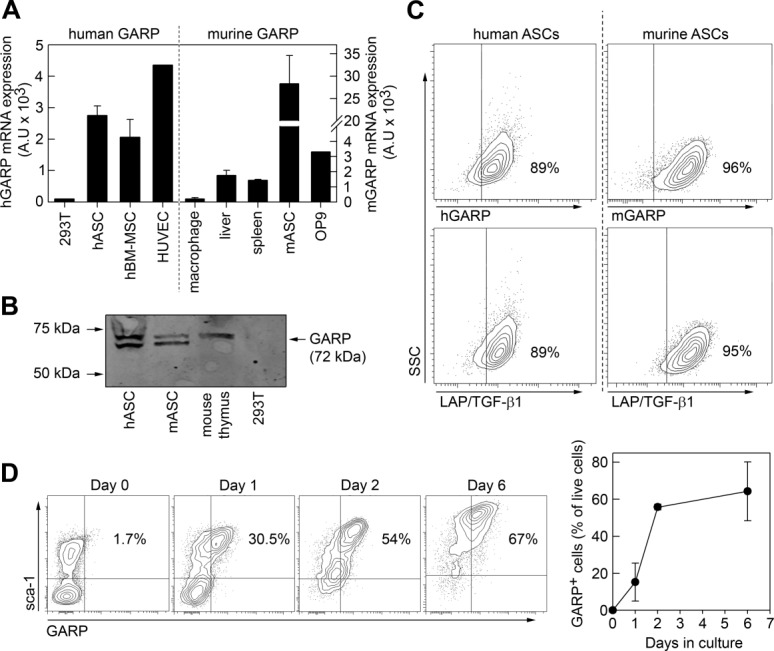
MSCs express GARP and LAP/TGF-β1 on their surface. (A): RT-qPCR analysis of GARP expression in human (left) and mouse (right) MSCs. hASCs and hBM-MSCs were analyzed together with human negative (293T) and positive (HUVEC) cell lines. Murine MSCs from adipose tissue (mASCs) and the MSC-line OP9 are shown in the right panel. As controls for murine samples we used BM-derived macrophages, mouse liver, and spleen. (B): Total protein from hASCs, mASCs, murine thymocytes, and 293T cells were analyzed by Western blot using an anti-mouse/human GARP antibody. (C): EDTA-harvested human and murine ASCs were stained for GARP (top) and LAP/TGF-β1 (bottom) surface expression and analyzed by flow cytometry. (D): Fat tissue from BALB/c mice was treated with collagenase type I and the resulting cell suspensions were stained for GARP and sca-1 expression before (day 0) and 1, 2, and 6 days after in vitro culturing and analyzed by flow cytometry. (A) and (D) show mean (SEM) of three independent experiments; (B) and (C) show a representative experiments out of >3. Abbreviations: GARP, glycoprotein A repetitions predominant; hASC, human mesenchymal stromal cells from adipose tissue; hBM, human bone marrow; LAP, latency-associated peptide; MSC, mesenchymal stromal cell; TGF-β1, transforming growth factor-β1.